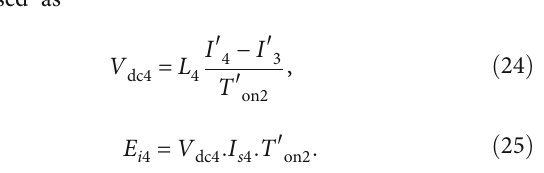
Figure 6: Modes of operation of proposed 3-phase seven-level Table 1: Speci fi cations of three-phase BMLDLC systems.